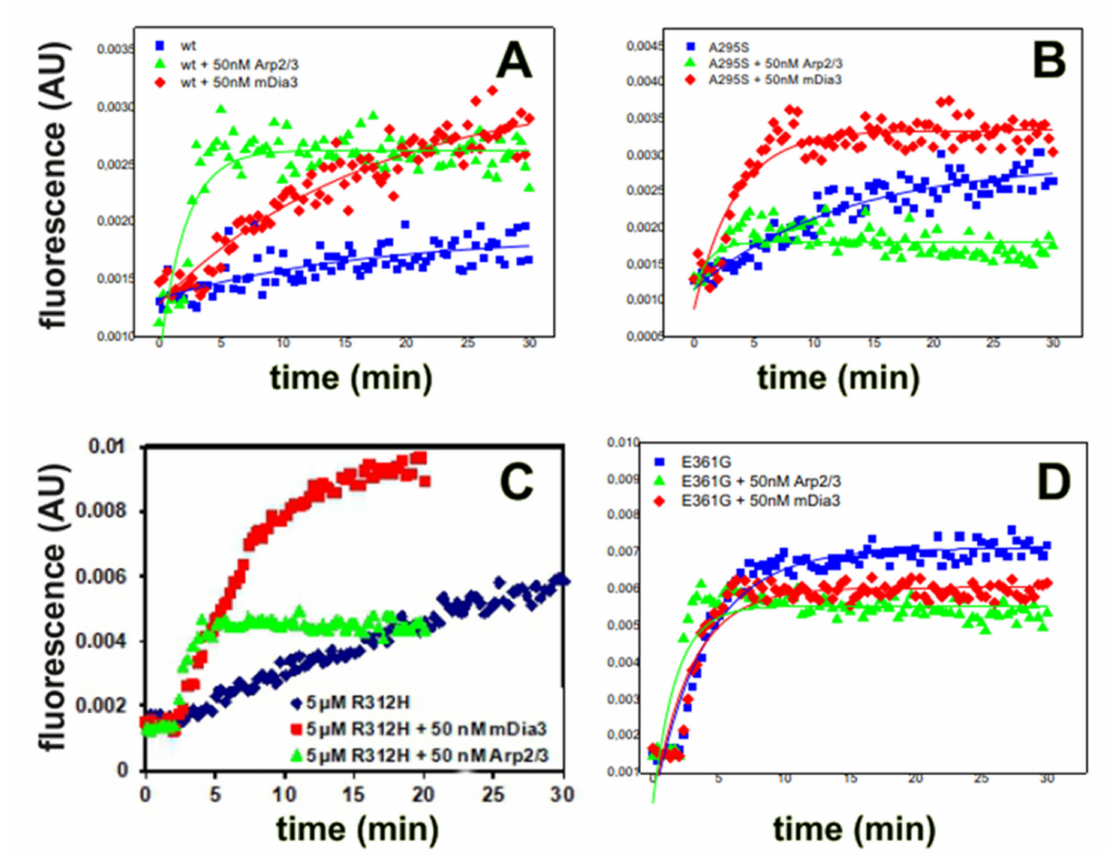
Figure 2. Polymerization of the purified c-actins in the presence of nucleators. ( A – D ) Influence of nucleators on the rates of polymerization of c-actins. ( A ) Recombinant wt-c-actin, ( B ) p.A295S, ( C ) p.R312H, and ( D ) p.E361G. All c-actins at 5 µ M and in the absence of presence of either 50 nM Arp2/3 complex or 50 nM mDia3-FH2 (for details, see text). Representative experiments from three for every c-actin variant. Table 1. Effect of polymerization nucleators on cardiac actin variants. Polymerization parameters of 5 µ M cardiac actin variants in the absence or presence of 50 nM Arp2/3 complex or 50 nM mDia3-FH2 (data taken from Figure 3D–G). The experiments were repeated three times with two different protein preparations with no significant